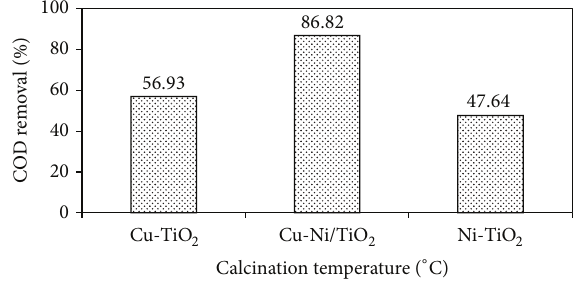
Figure 10: Effect of Cu-Ni codeposition on % COD removal using Cu/TiO 2 , Ni/TiO 2, and Cu-Ni/TiO 2 photocatalysts (photocatalysts loading = 1g ⋅ L −1 ; calcination temperature = 200 ∘ C; DIPA concen- tration = 100 ppm; irradiation time = 1